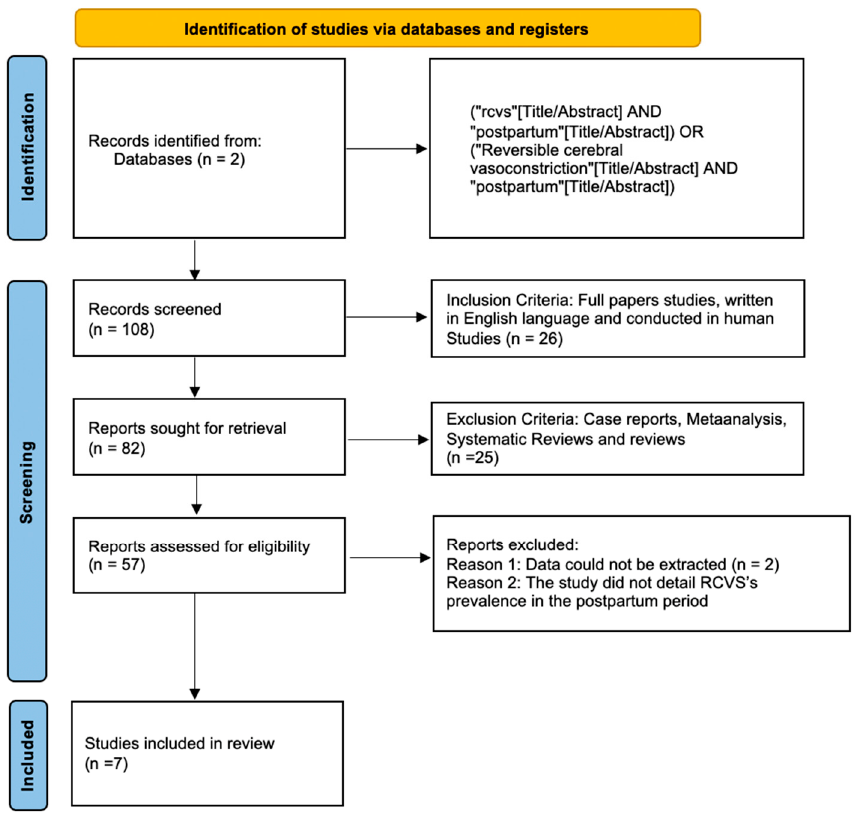
Figure 1. Flowchart of the